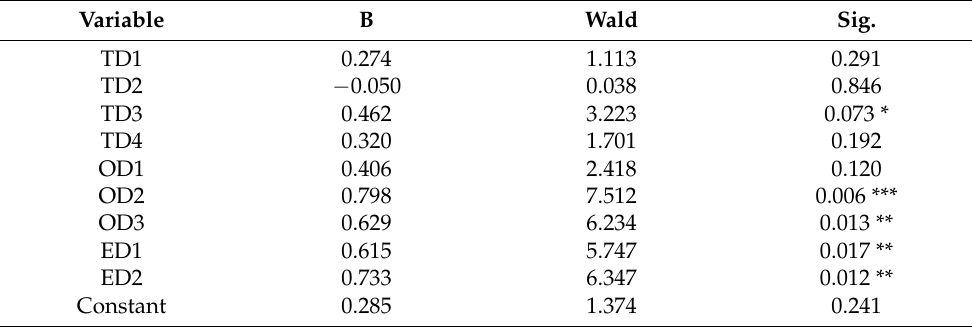
Table 6. Logistic